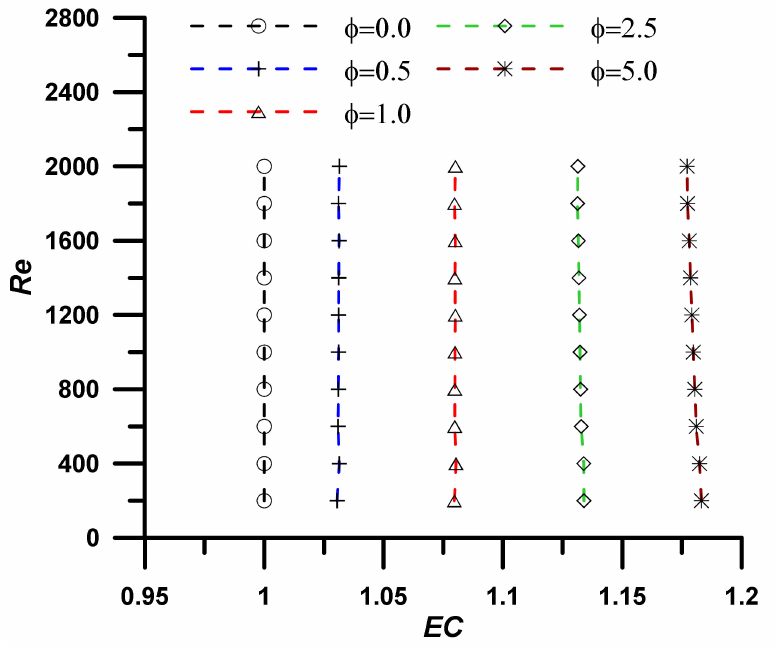
Figure 6. Evaluation performance criteria at T = 313.15 K for investigated nanoparticle